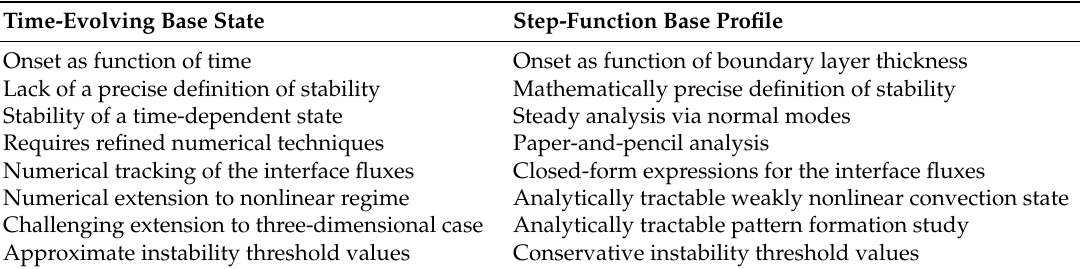
Figure 2. A schematic diagram contrasting the two base configurations. Table 1. Table contrasting the stability characteristics of the two base